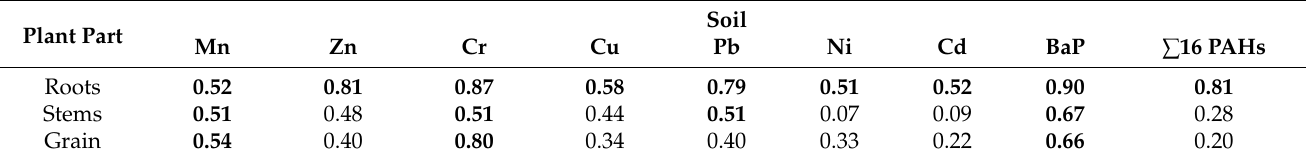
Table 4. Correlation between the content of pollutants in soil and various parts of wheat plants ( Triticum aestivum